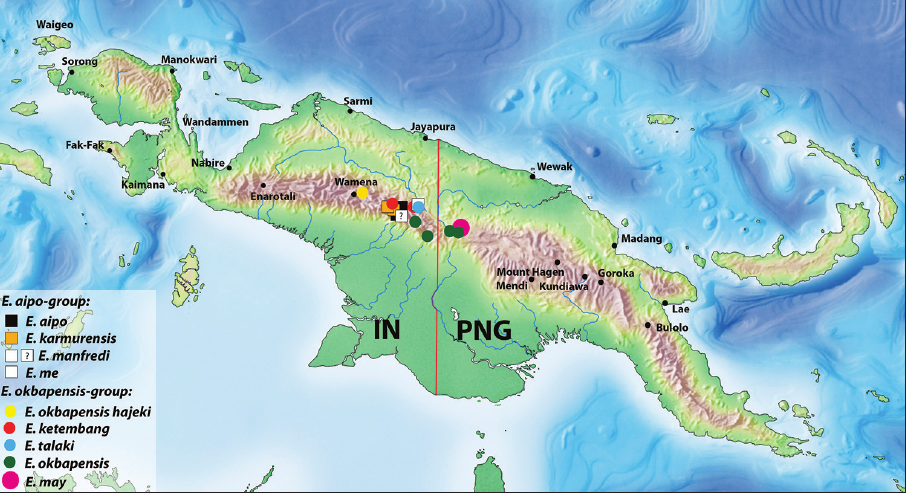
Figure 12. Map of New Guinea showing distribution of the species of both groups. The white square with a question mark indicates the male from Aipomek-Tanime area, which most likely belongs to E. manfredi (Balke,